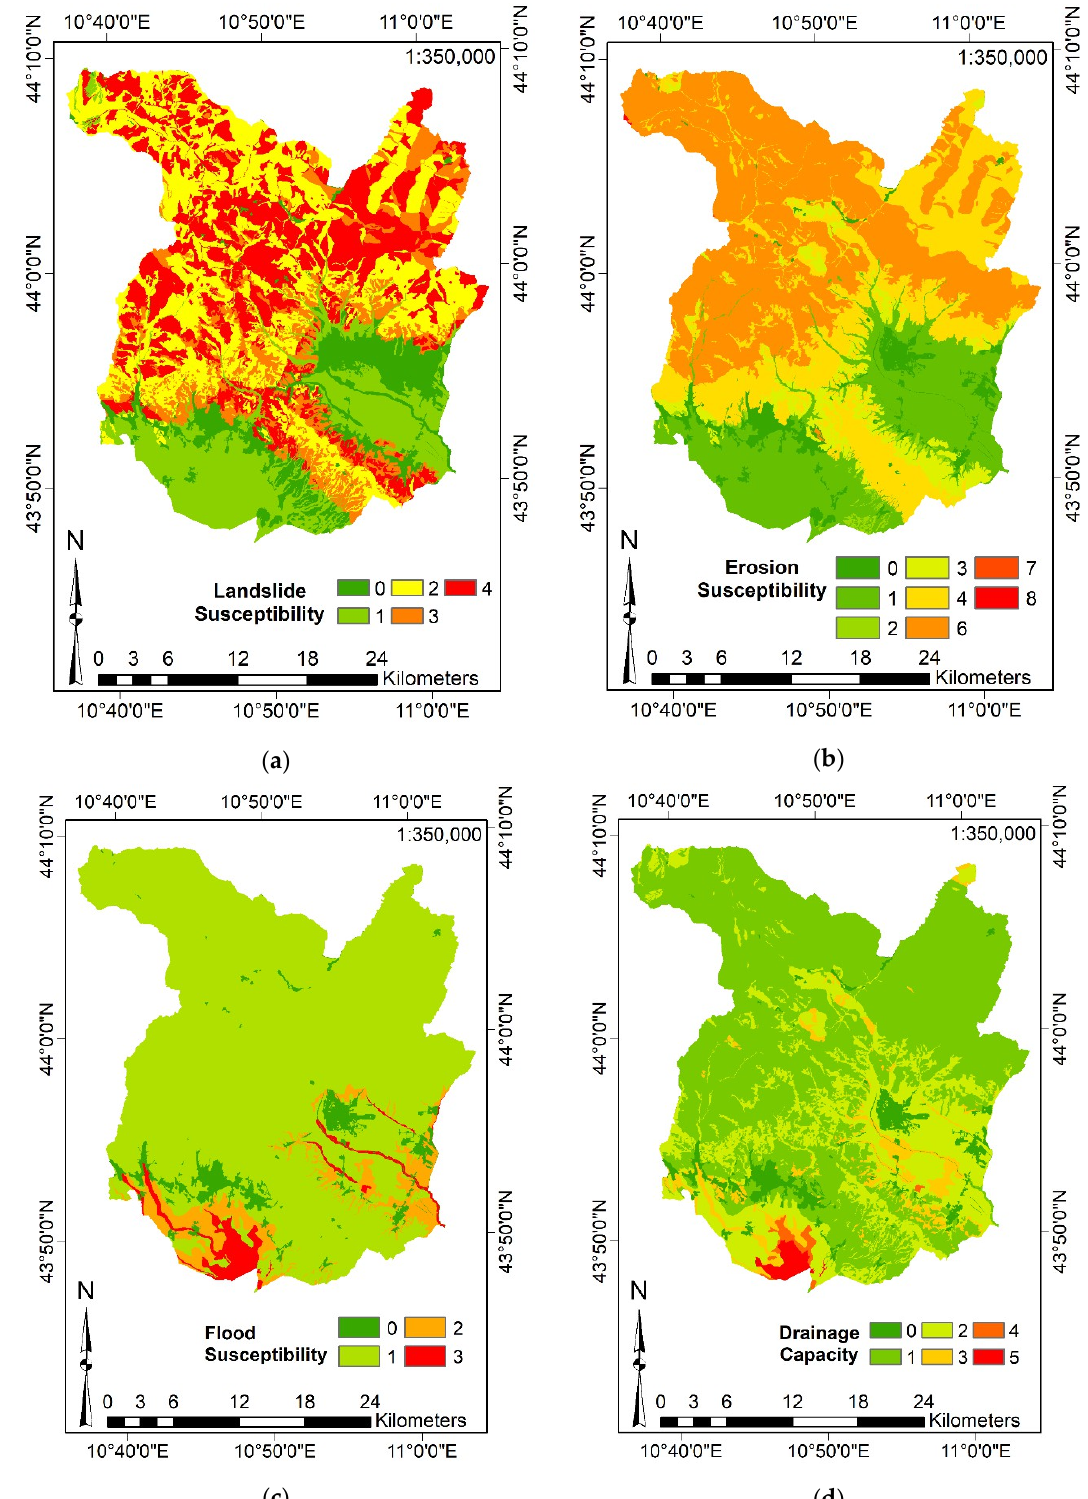
Figure A3. Information collected—susceptibilities: ( a ) Landslide susceptibility; ( b ) Erosion susceptibility; ( c ) Flood susceptibility; ( d ) Drainage capacity of the subsoil.